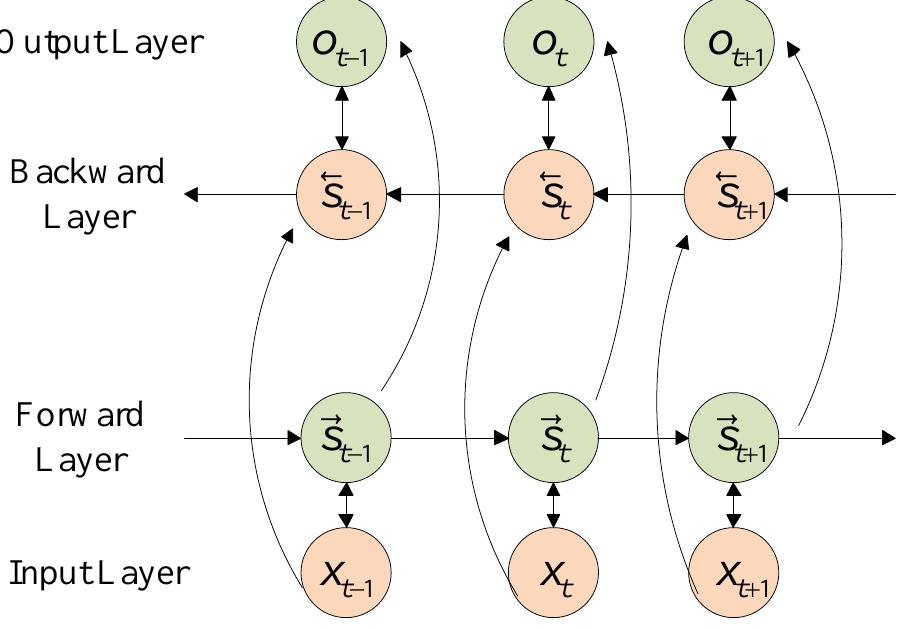
Figure 3. Basic structure of bidirectional LSTM. The bidirectional LSTM neural network is different from the traditional feed-forward mechanism neural network. The internal nodes in each layer do not connect with each other in bidirectional LSTM. A directional loop is introduced in the connection of hidden layers, foregoing information; results are memorized and stored in the memory unit, which can improve the association of single pieces of information in different time series. The current output of the neural network is determined bycombining the previous output and the current input. However, with the increasing amount of input data in the time series, there will be gradient disappearance and gradient explosion problems due to the lack of delay window